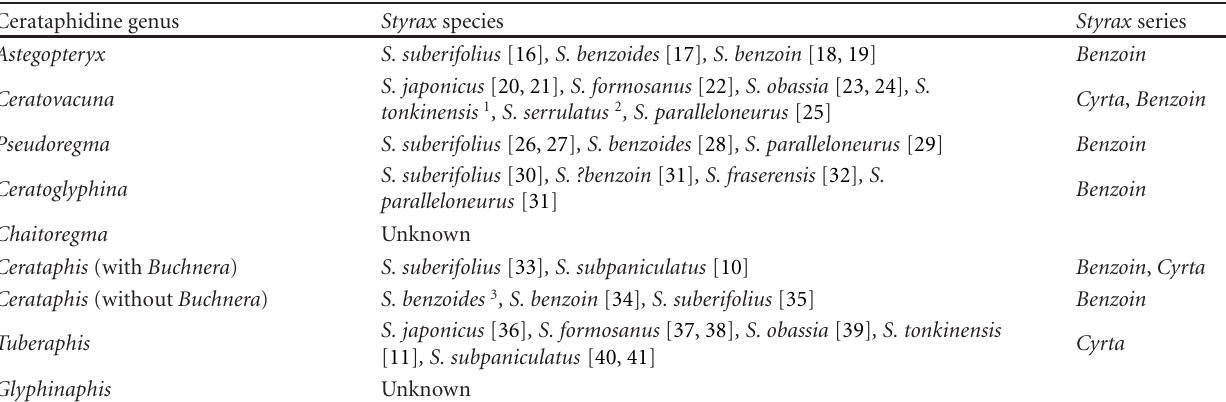
Table 1: Primary hosts of Cerataphidini.